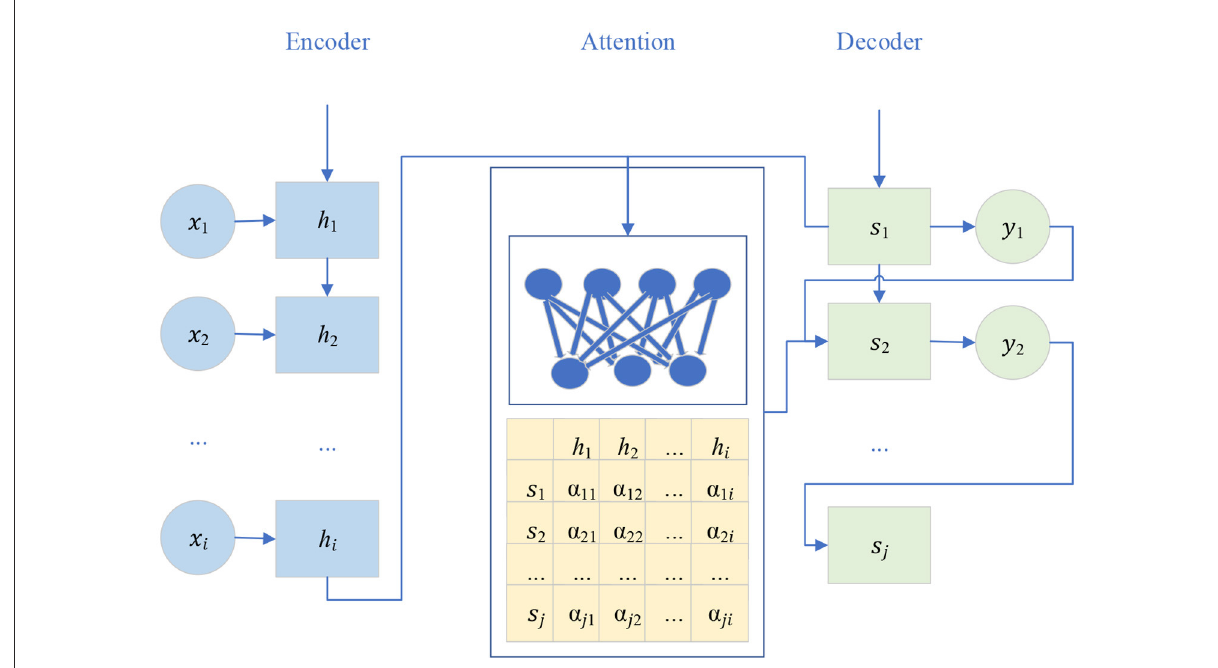
FIGURE5 Schematic diagram of Sequence-to-Sequence model based on attention mechanism.